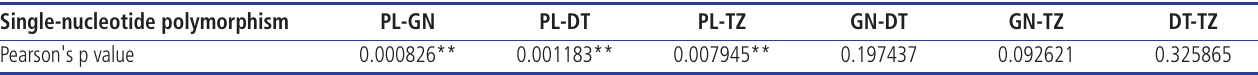
Table 7. The haplotype Pearson's p value of single-nucleotide polymorphisms in the four yak breeds Single-nucleotide polymorphism